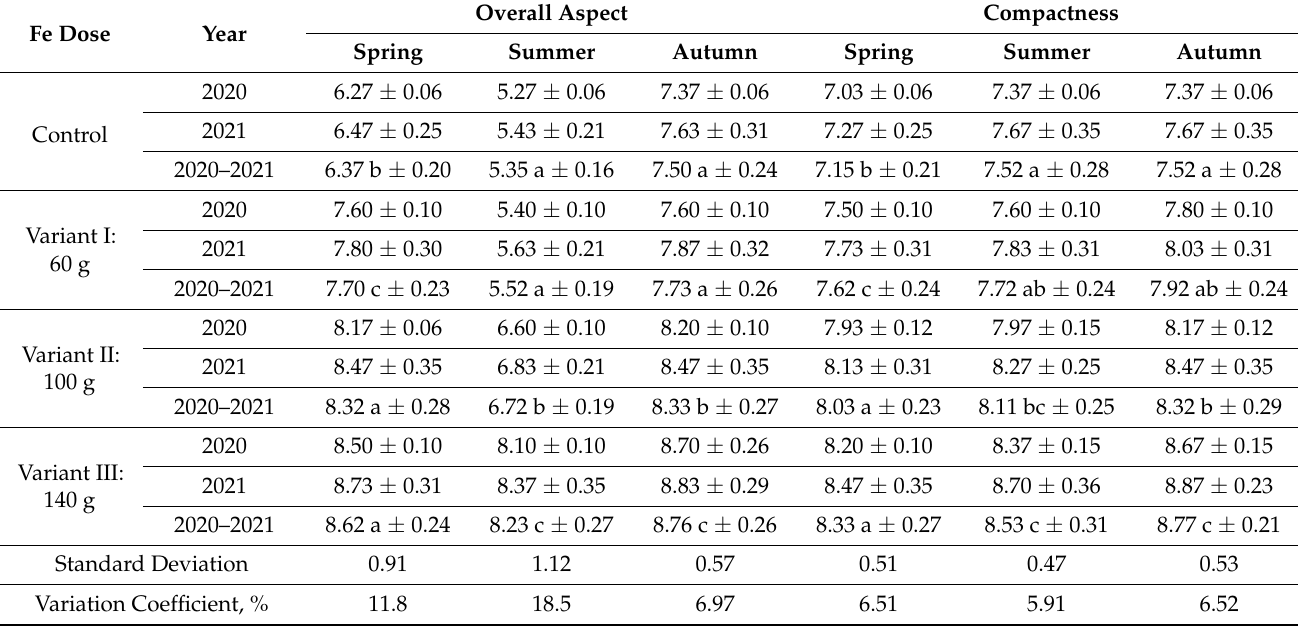
Table 2. Scores for main lawn properties depending on fertilization